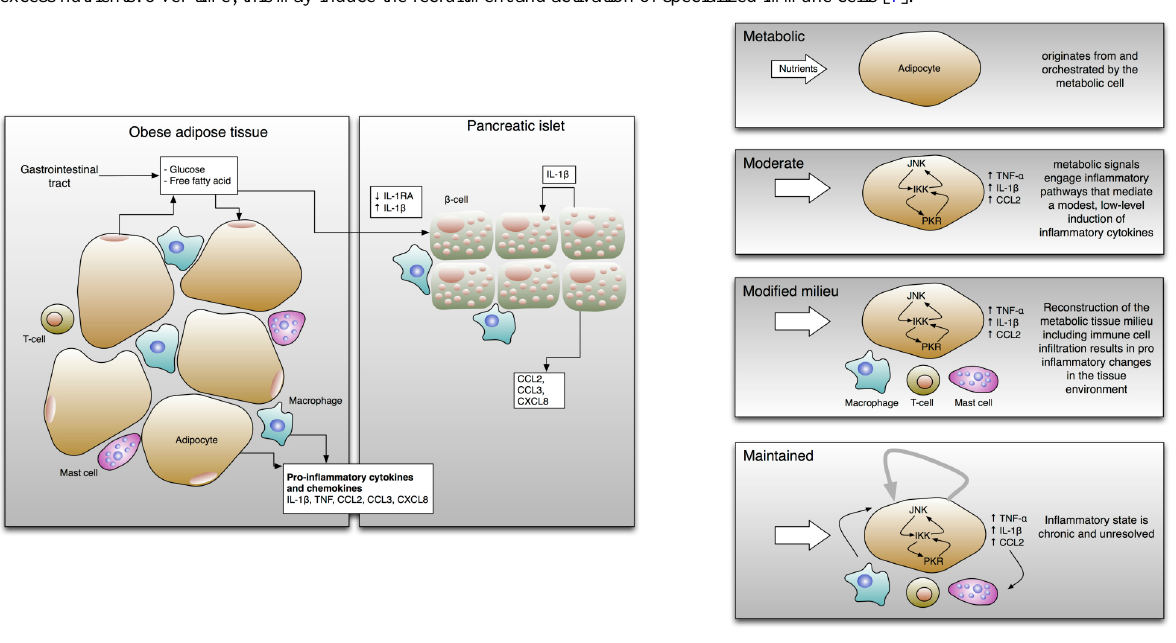
Figure 1. Left: Excessive levels of nutrients, including glucose and free fatty acids, stress the pancreatic islets and insulin-sensitive tissues such as adipose tissue, leading to the local production and release of cytokines and chemokines (eg, IL-1 β , TNF, CCL2, CCL3, and CXCL8). Furthermore, production of IL-1 receptor antagonist (IL-1RA) by β -cells is decreased. As a result, immune cells will be recruited, which contribute to tissue inflammation [14]. Right: Hallmarks of metaflammation. The first feature of this type of inflammation in obese individuals is that it originates from signals within metabolic cells such as adipocytes. Second, the metabolic signals trigger inflammatory intracellular signaling pathways that mediate downstream inflammatory responses (eg, JNK, IKK, or PKR pathways). The activation of these mediators induces a low level of chronic inflammation in response to the excess nutrients. Over time, this may induce the recruitment and activation of specialized immune cells [1].